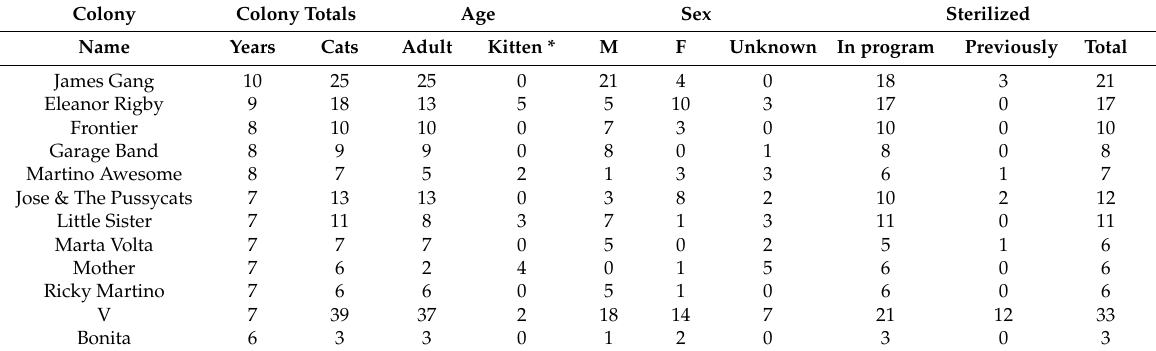
Table 2. Colony characteristics: years in program, total cats, age (* <12 weeks of age), sex, and sterilization status. Colony Colony